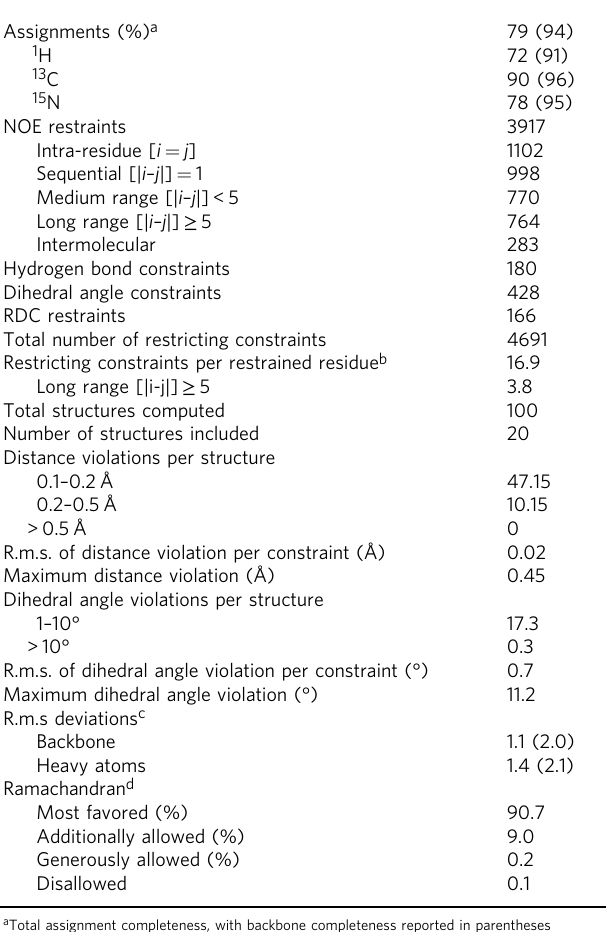
Fig. 2c, overexpression of WT CARD9 weakly induced NF- κ B